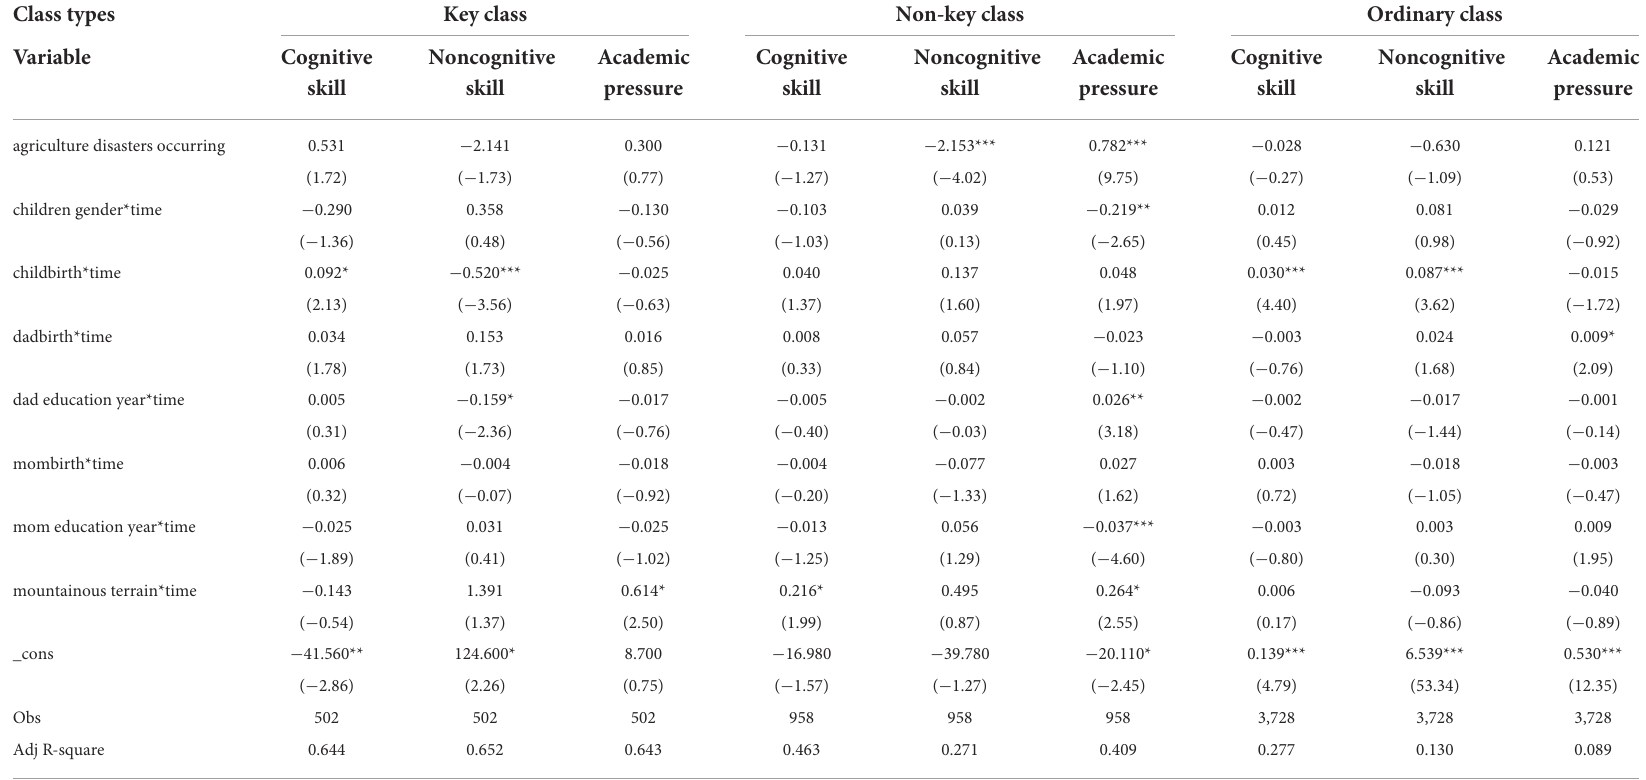
TABLE 3 The results of class types heterogeneity